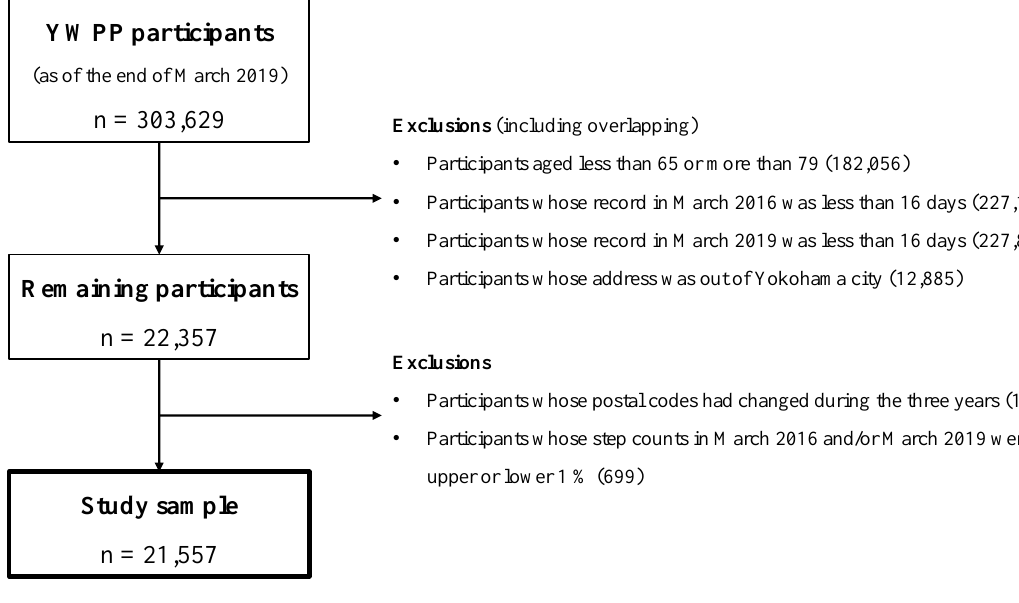
Figure 2. Sample selection flow diagram.